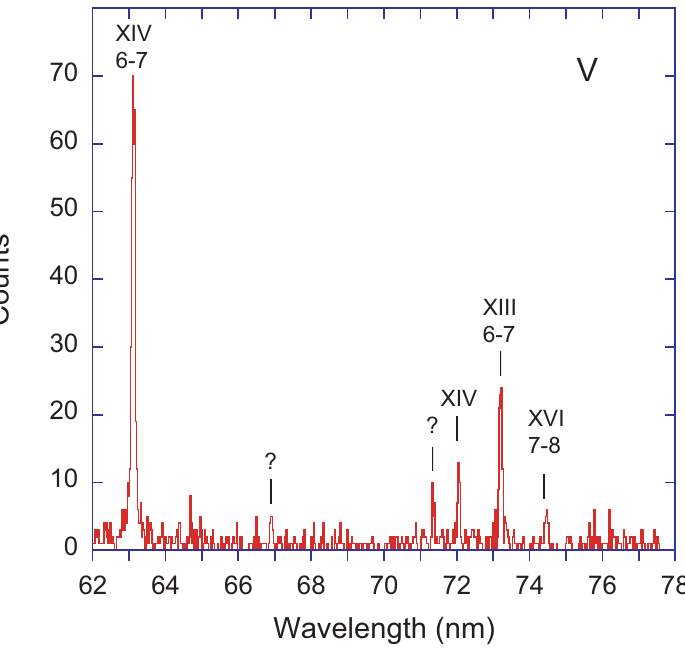
Figure 11. Beam-foil spectrum of V at an ion beam energy of 30MeV. Observation at the foil. Line width (FWHM) 0.075nm. The strongest lines are identified by the spectrum number. Several spectral features can be identified with yrast transition